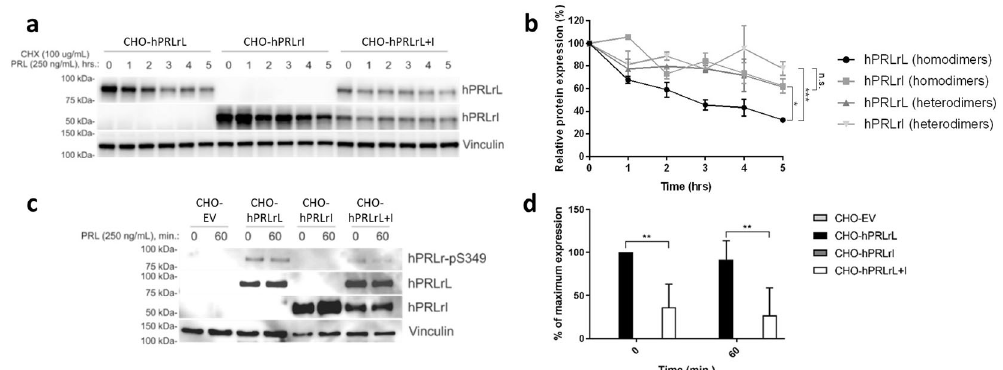
Fig. 4 hPRLr heterodimer versus homodimer differential stability. Chinese hamster ovary (CHO) cells (PRLr-null) were transiently- transfected with either hPRLrL, hPRLrI, or both isoforms concurrently (at a 1:1 ratio). a Transfectants were simultaneously stimulated with cycloheximide (CHX; 100 µg/mL) and prolactin (PRL; 250 ng/mL), and lysates were harvested once per hour for 5 consecutive hours. Protein degradation was quanti fi ed, via densitometry of band intensity, in b and t 1/2 was extrapolated from each respective slope. c Phosphorylation status of the hPRLr phosphodegron was assessed using a pS349-speci fi c antibody (gift of Dr. Serge Fuchs), and d band intensity was quanti fi ed via densitometry. * p < 0.05, ** p < 0.01, *** p < 0.005, n = 3. Data is shown as mean ±